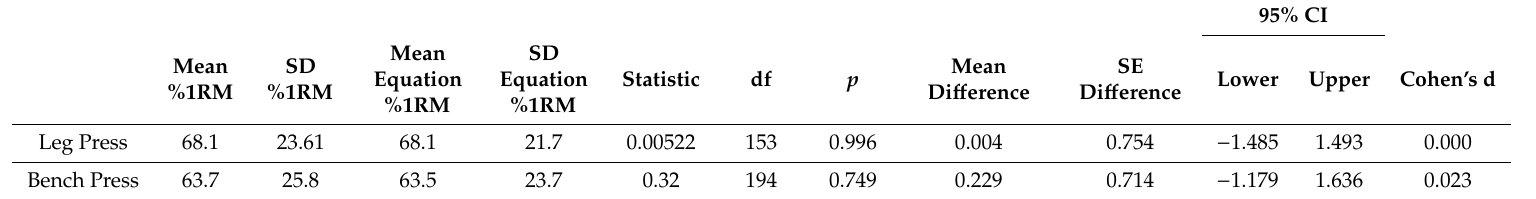
Table 3. T-test of paired samples for the di ff erence between methods.